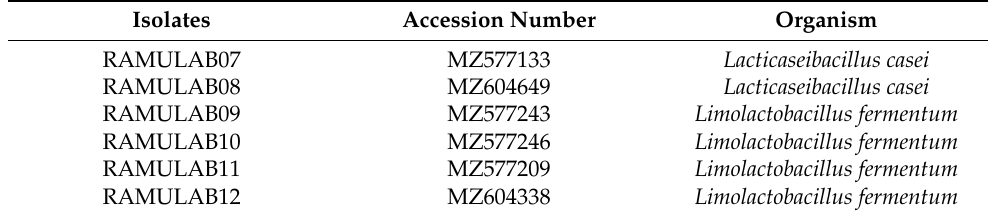
Table 8. The NCBI GenBank accession number of the isolates and the